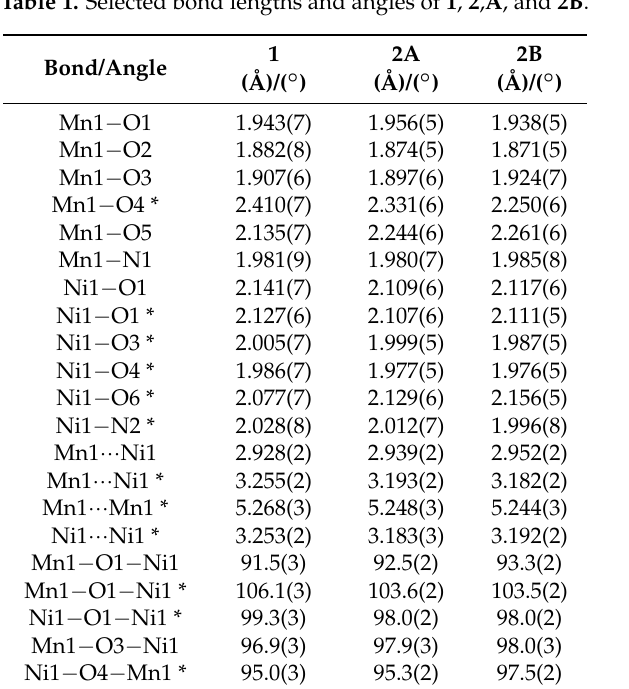
Figure 2. Crystal structure of 1 . ( a ) molecular structure, ( b ) modeling view for the intramolecular π − π stacking between naphthyl groups, ( c ) modeling view for the distortion of (L) 2 − in coordination. Thermal ellipsoids of (a) are drawn with 50% probability, hydrogen atoms are omitted for clarity. Symmetry code: (*) − x + 1, − y , − z. Table 1. Selected bond lengths and angles of 1 , 2 , A , and 2B